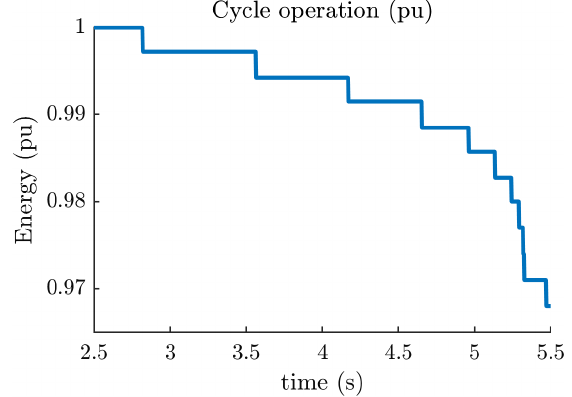
FIG. 2. Typical treatment steps starting at the maximum energy, irradiating the distant part of the tumor, and decreasing in energy and in time for each closest tumor slices.